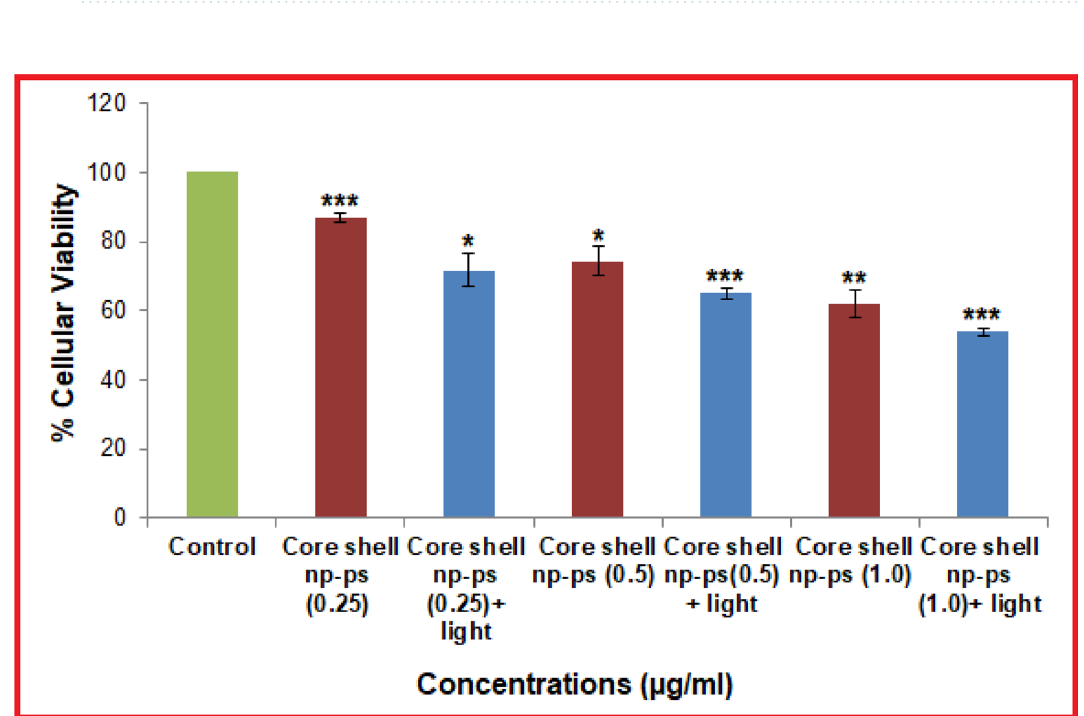
Figure 3. Cytotoxicity assay: Percentage viable cells as measured after 24 h, after treatment with TBO–chit– Au–AgNPs in absence and presence of laser irradiation. Data expressed as mean ± SD, n = 3 ( p -value * p < 0.01; ** p < 0.001, *** p < 0.0001, ns = not